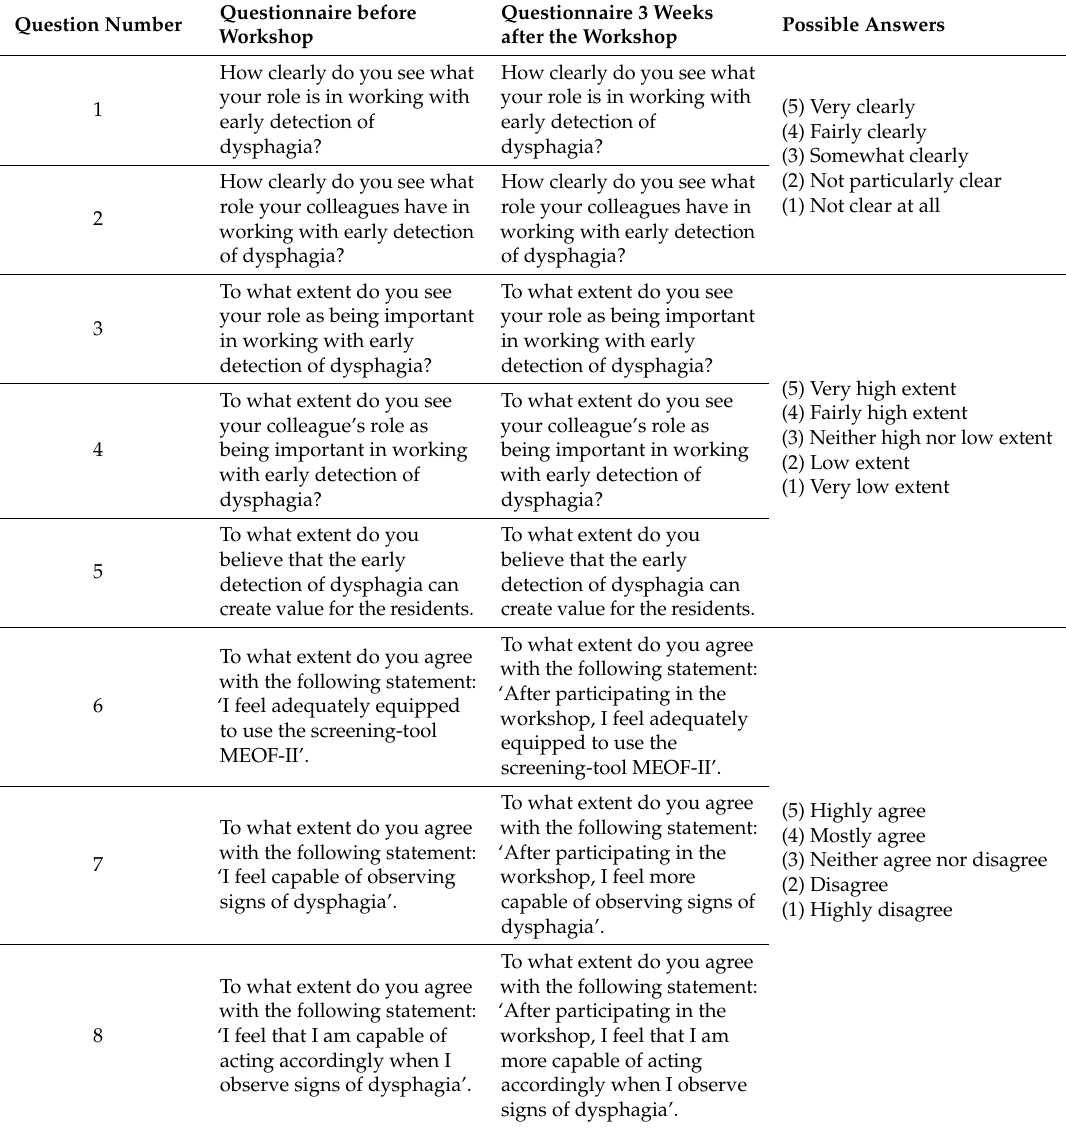
Table 1. Questionnaire handed out before and 3-4 weeks after the